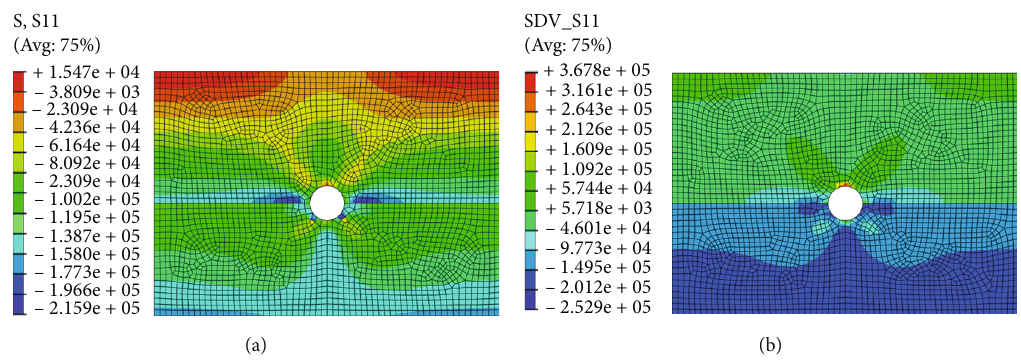
Figure 12: Horizontal stress distribution after excavation. (a) No cracks. (b) Consider cracks.